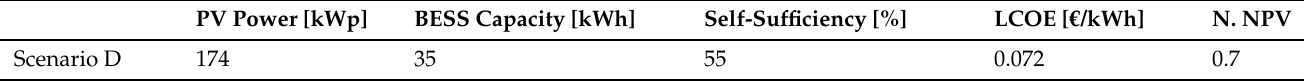
Table 4. Optimization results for the Scenario D considering the minimum LCOE cost function.